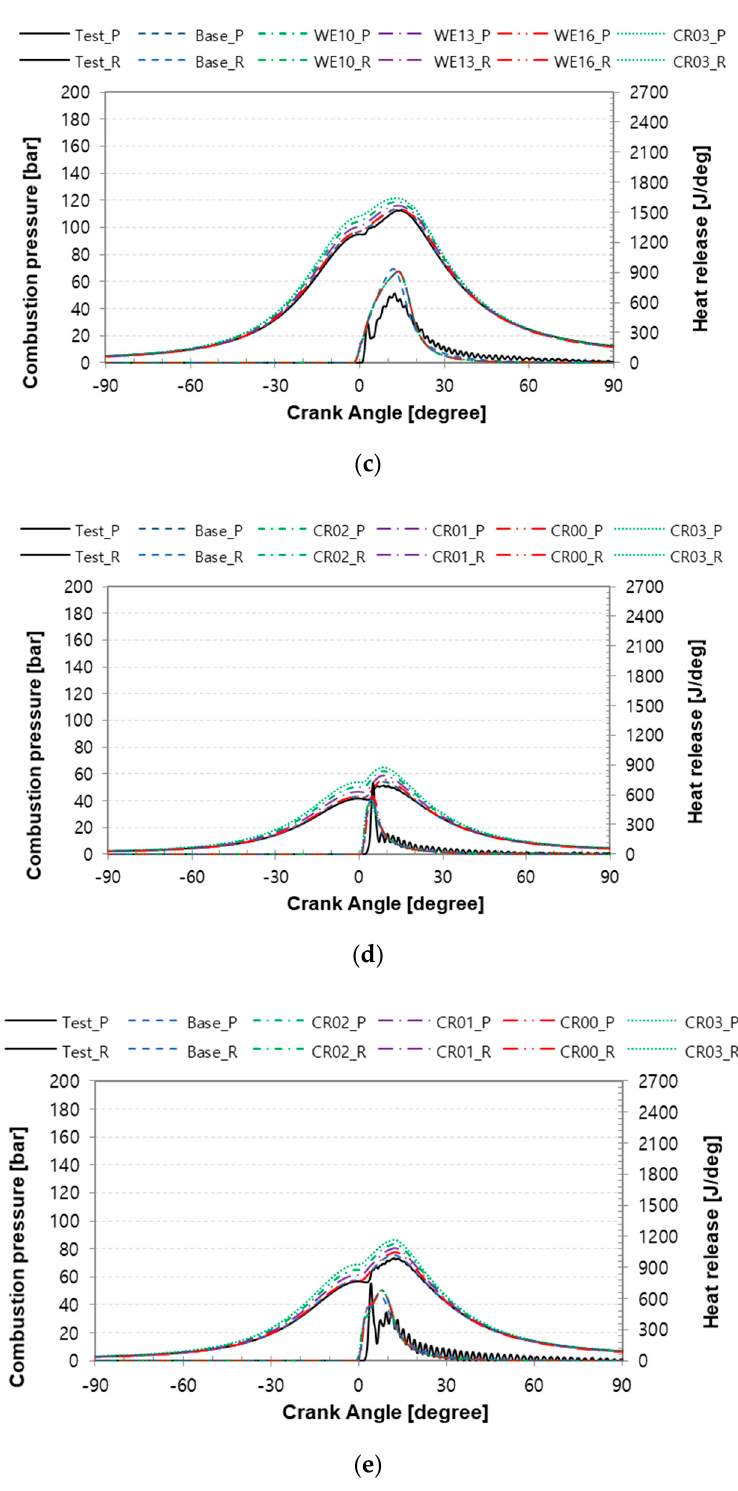
Figure 6. Combustion pressure and heat release characteristics versus the compression ratio of the turbocharger at Emulsified MDO 16%. ( a ) 100% of engine loads. ( b ) 75% of engine loads. ( c ) 50% of engine loads. ( d ) 25% of engine loads. ( e ) 10% of engine loads.